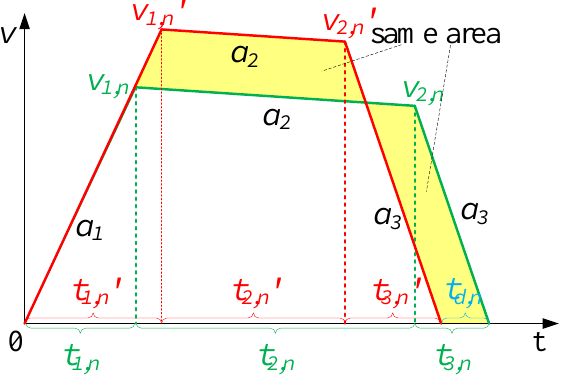
Figure 3. Drive faster to make up the